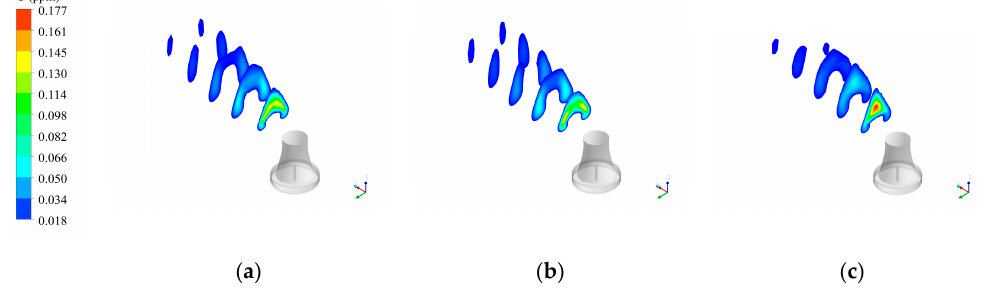
Figure 22. Comparisons of the mean pollutant concentration distribution downstream of cooling tower: ( a ) RANS; ( b ) URANS; ( c ) LES.